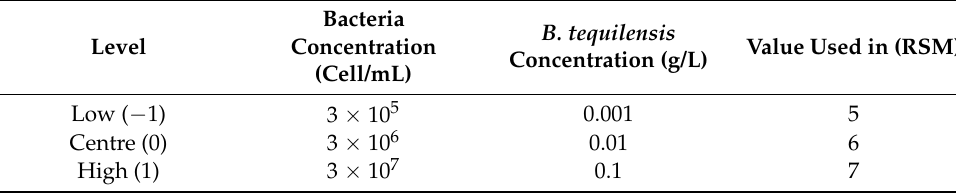
Table 2. B. tequilensis concentration as the main factor in (RSM).